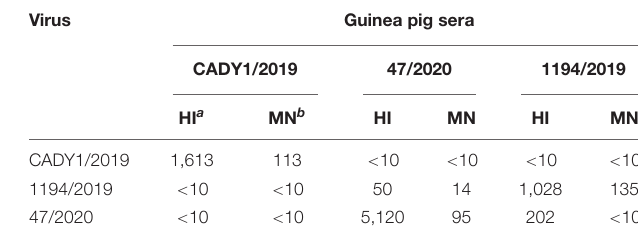
TABLE 3 | The antigenicity relationship between CADY1/2019 and human H3N2 influenza viruses.